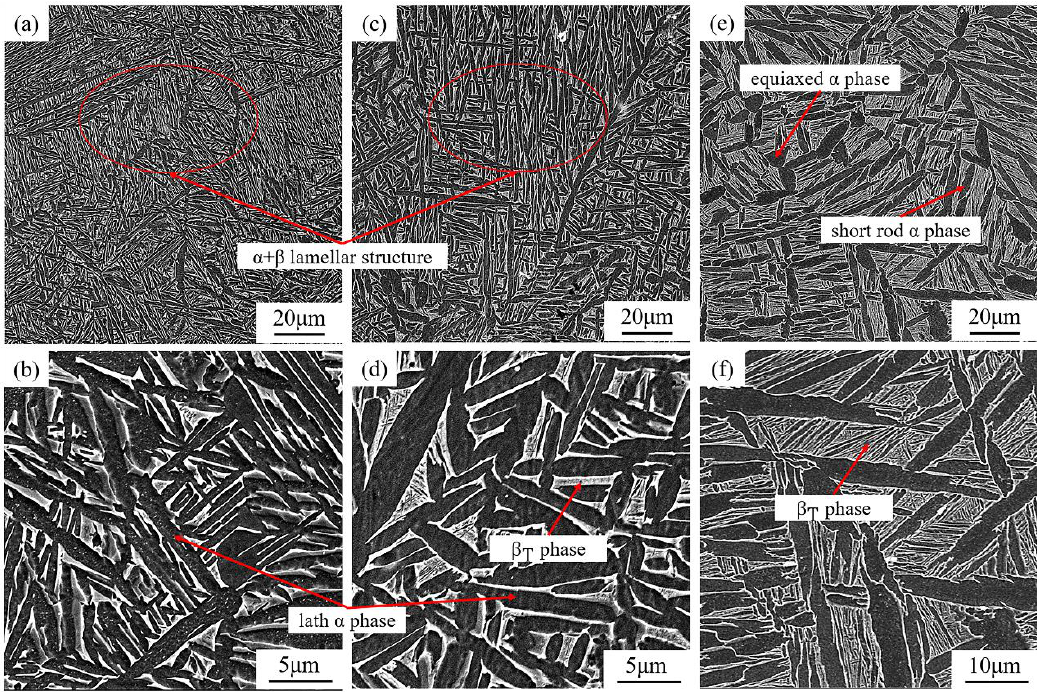
Figure 5. SEM micrographs of L-PBF TA15 heat-treated at ( a ) 850 °C , ( c ) 900 °C and ( e ) 950 °C for 2 h; ( b , d , f ) show higher magnification of the micrographs.